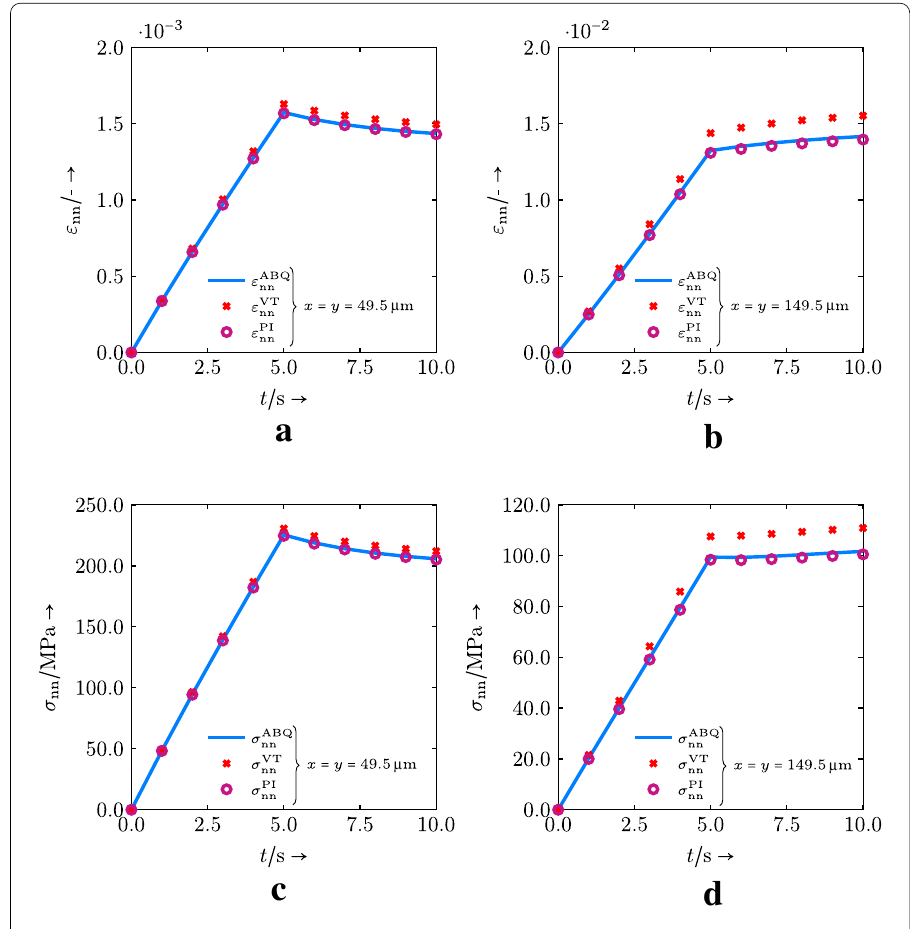
Fig. 15 Results for a , b ε nn and c , d σ nn along the simulation time: The data is plotted for x = y = { 49 . 5 , 149 . 5 } µ m. Compared to the VT approach, the PI approach stays for stresses and strains closer to the sharp-interface solution in both, a purely linear elastic ( x = y = 49 . 5 µ m) and a linear visco-elastic ( x = y = 149 . 5 µ m)